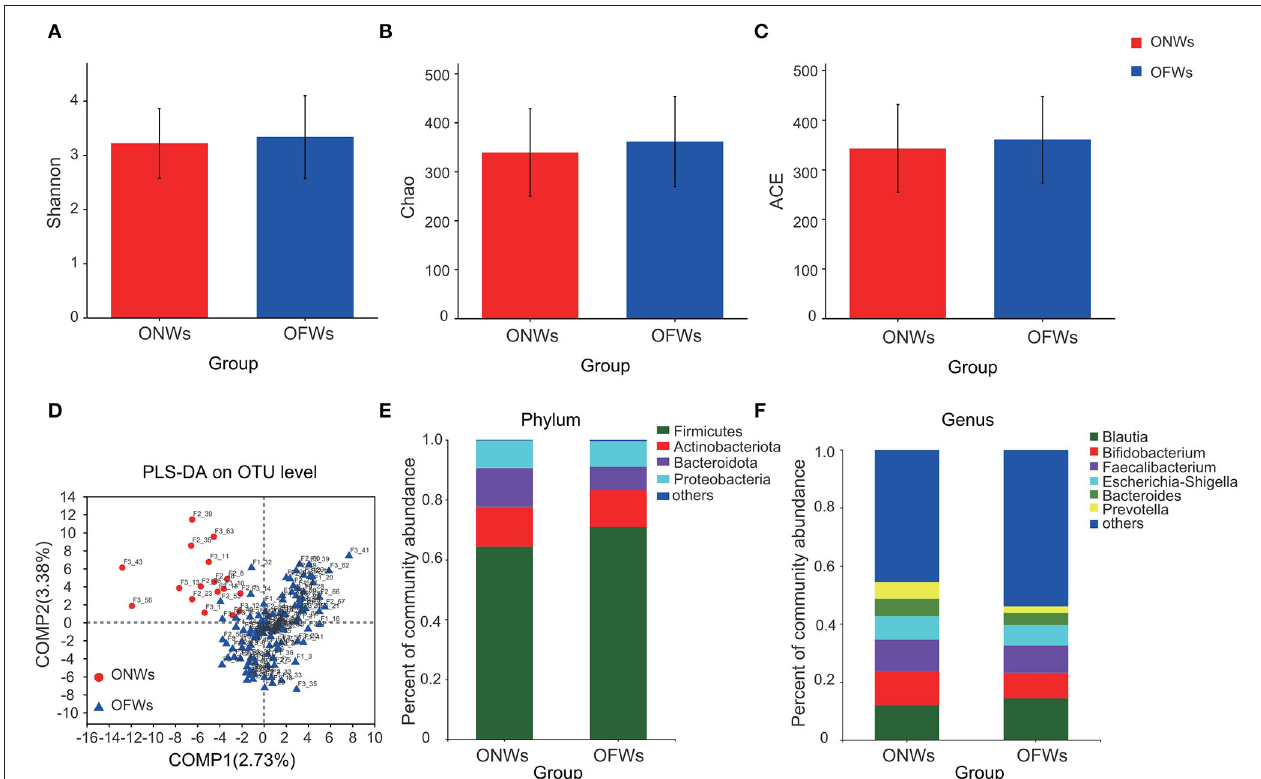
FIGURE 1 | The diversity and relative abundances of the microbial community of ONWs and OFWs. Alpha-diversity sanalysis with Shannon (A) , Chao (B) , and ACE (C) index separately. (D) PLS-DA on OTU level. Relative abundance of the microbial community at phylum (E) and genus levels (F) . ONWs, onshore workers; OFWs, offshore